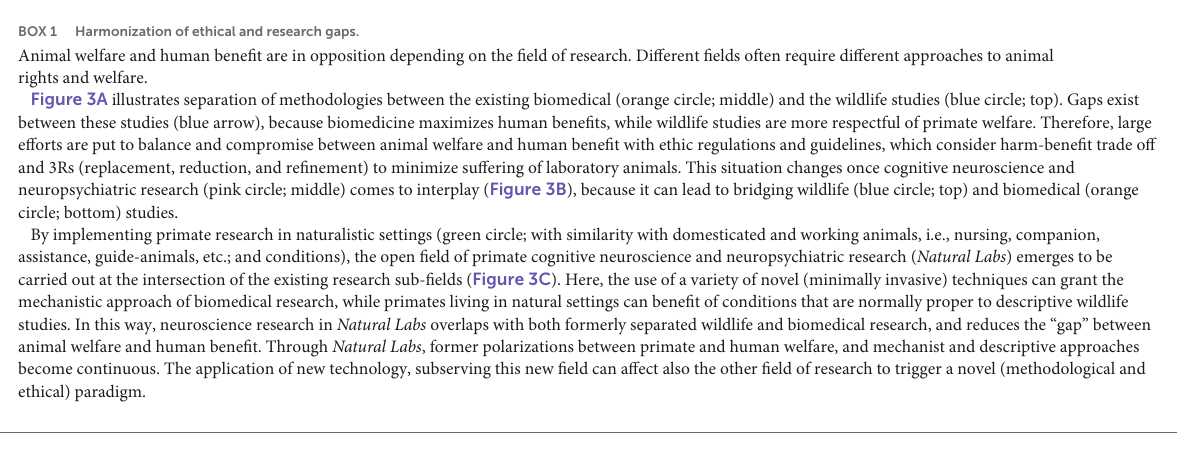
BOX1 Harmonizationofethicalandresearchgaps. Animal welfare and human benefit are in opposition depending on the field of research. Different fields often require different approaches to animal rights and welfare. Figure 3A illustrates separation of methodologies between the existing biomedical (orange circle; middle) and the wildlife studies (blue circle; top). Gaps exist between these studies (blue arrow), because biomedicine maximizes human benefits, while wildlife studies are more respectful of primate welfare. Therefore, large efforts are put to balance and compromise between animal welfare and human benefit with ethic regulations and guidelines, which consider harm-benefit trade off and 3Rs (replacement, reduction, and refinement) to minimize suffering of laboratory animals. This situation changes once cognitive neuroscience